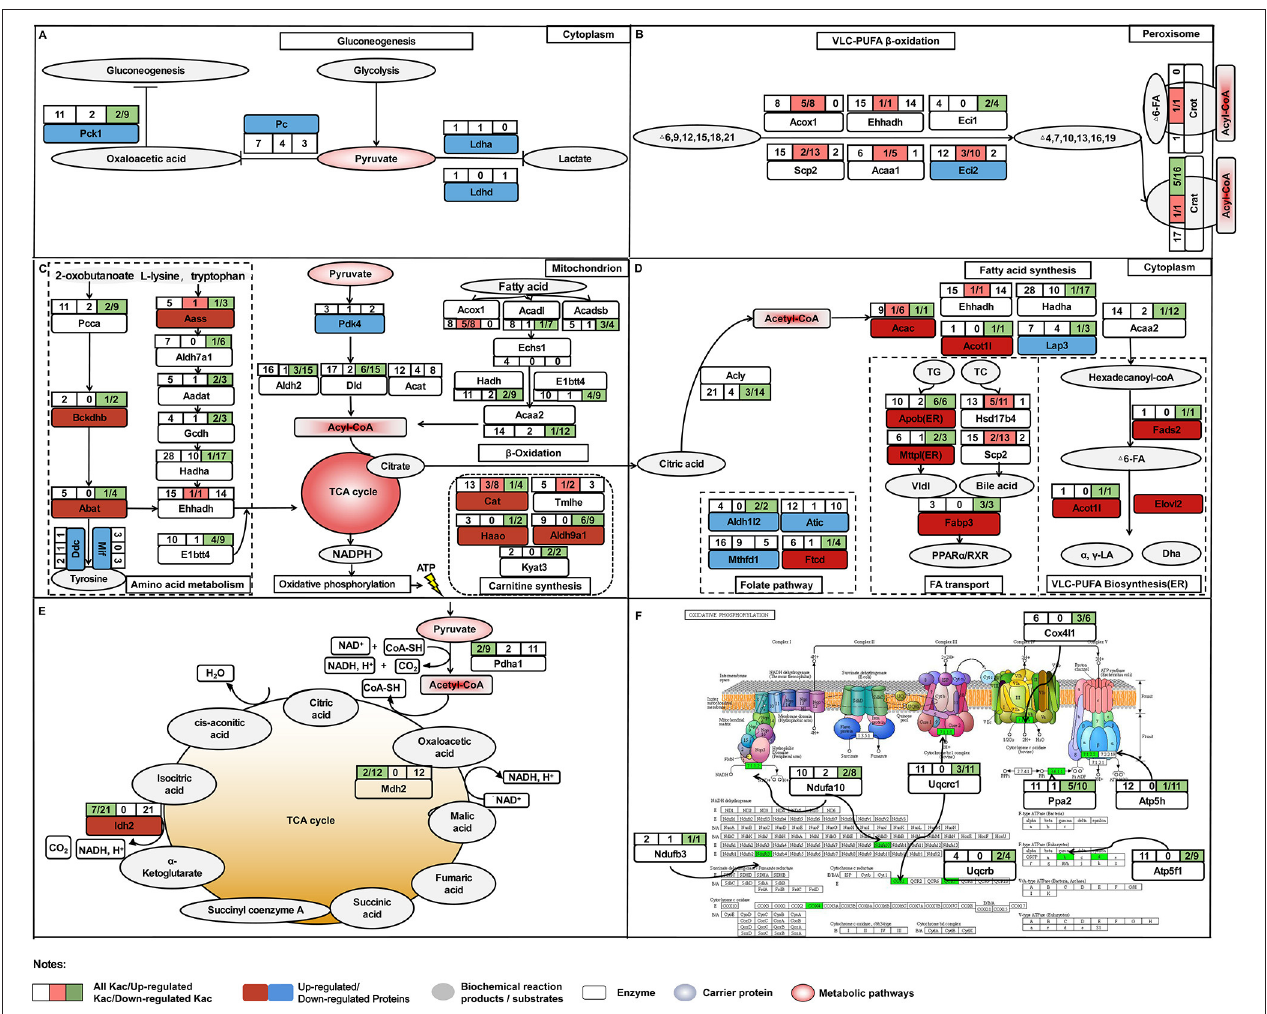
FIGURE 10 | The comprehensive proteome and acetyl-proteome atlases of liver in pre-laying and peak-laying hens. The acetylated proteins involved in the aerobic oxidation process of sugar including glycolysis, pyruvate metabolism, TCA cycle and oxidative phosphorylation, fatty acid b-oxidation, carnitine synthesis, and some amino acid metabolism. (A) The acetylated proteins involved in glycolysis. (B) The acetylated proteins involved in pathways of PUFA oxidation in peroxisome. (C,D) The acetylated proteins involved in pathways including fatty acid synthesis, polyunsaturated fatty acid biosynthesis, fatty acid transport, and folate pathway in cytoplasm. (E) The acetylated proteins involved in TCA cycle. (F) The acetylated proteins involved in the process of oxidative phosphorylation. Dark red boxes represent significantly upregulated proteins, light blue boxes represent significantly downregulated proteins. The circle indicates the processes of TCA cycle. Three consecutive squares represent the number of Kac sites (all/up/down). Top left box shows the numbers of all Kac sites for an individual protein. Top right box shows the numbers of all upregulated Kac sites for an individual protein; the number before the semicolon represents the number of significantly upregulated Kac sites. Bottom right box indicates the number of all downregulated Kac sites for an individual protein; the number before the semicolon represents the number of significantly downregulated Kac sites. The pink color represents the protein with significantly upregulated Kac sites, while green color represents significantly downregulated Kac